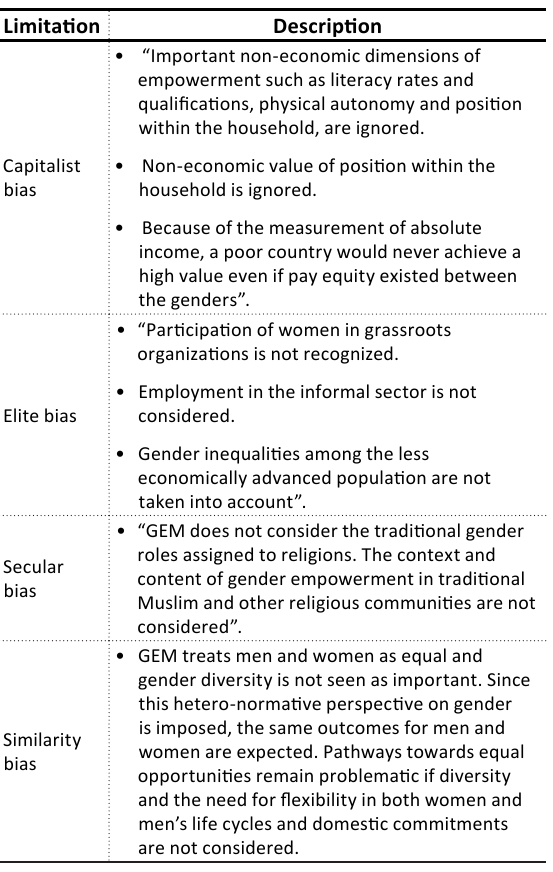
Table 1. GEM dimensions and their inherent biases